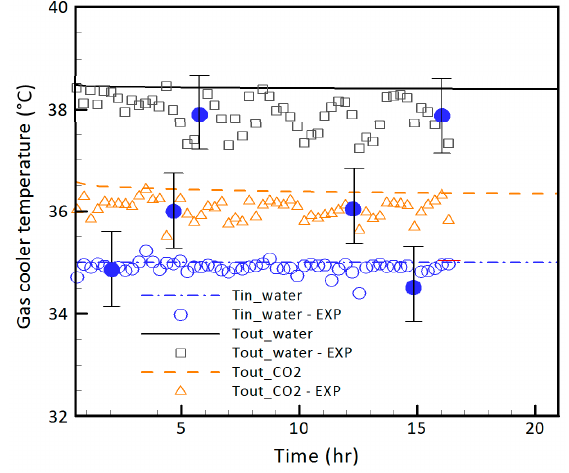
Figure 3. Gas cooler temperatures.